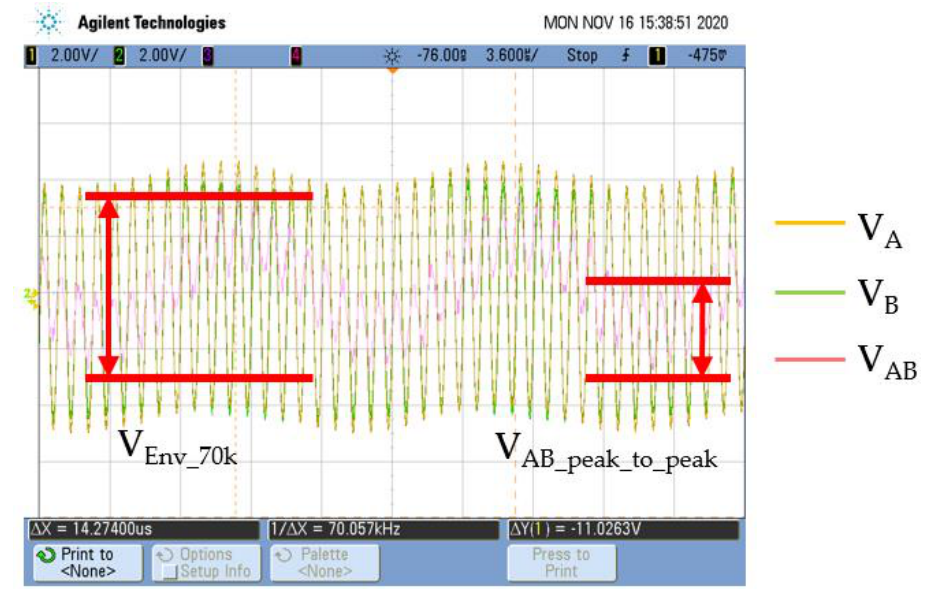
Figure 16. Measured voltages, V A , V B , and V AB at 7 cm apart in powering. Table 4. Measured V AB _ peak_to_peak and V ENV _70k according to distance between the transmitter and receiver coils.